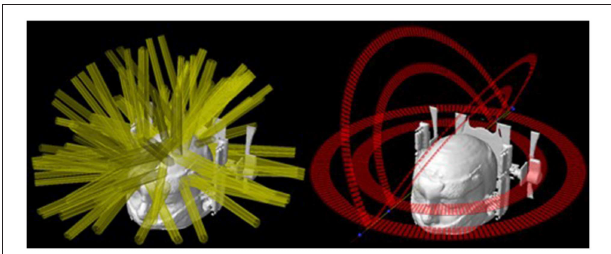
FIGURE 1 | Field arrangements for two treatment techniques. (Left) 3D-CRT with 8 isocenters and 62 beams. (Right) VMAT with 1 isocenter and 6 arcs.